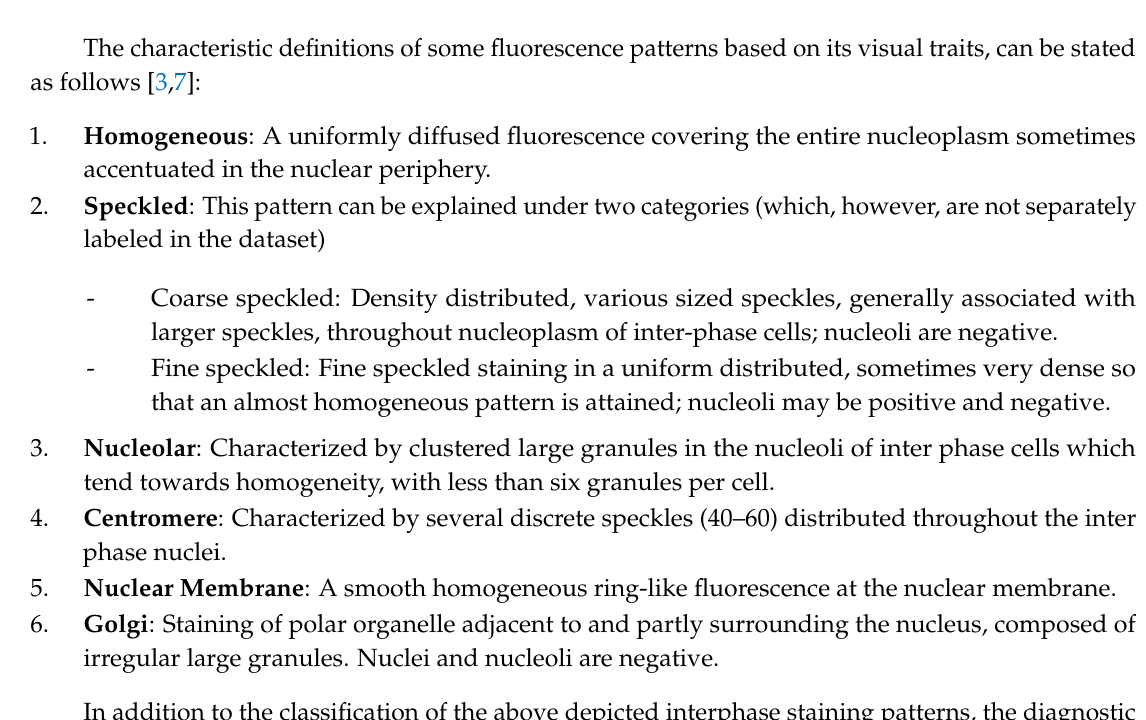
Figure 1. Fluorescence patterns